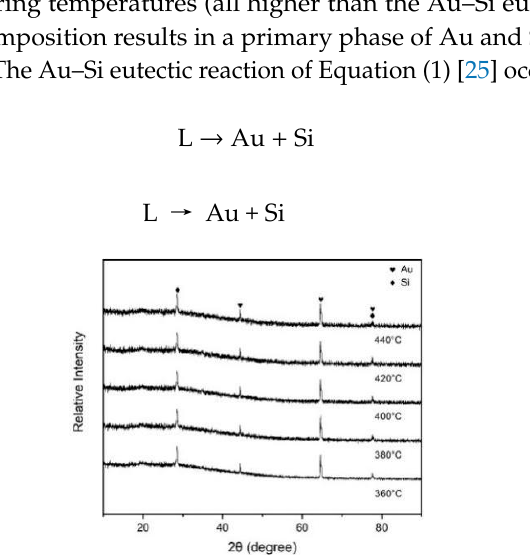
Figure 5. Patterns of joints at different soldering temperatures.